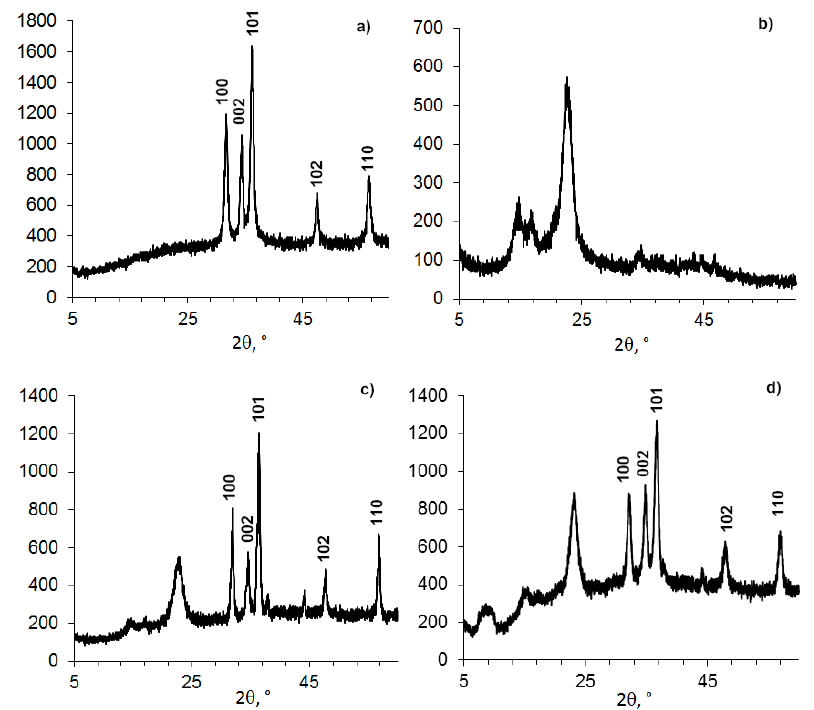
Figure 1. Powder XRD patterns of BC-ZnO samples: ( a ) ZnO NPs-PEG, ( b ) BC powder, ( c ) BC film–ZnO NPs, and ( d ) BC powder–ZnO NPs. film–ZnO NPs, and ( d ) BC powder–ZnO